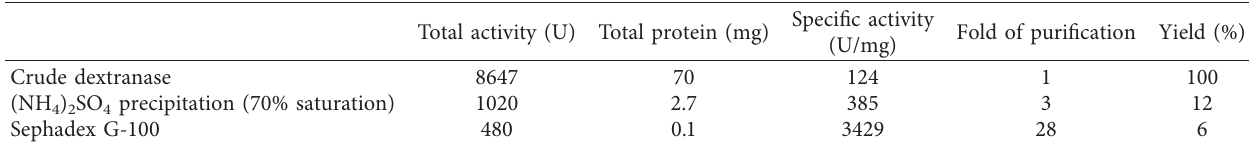
Table 1: Parameters related to purified dextranase from EGY strain.